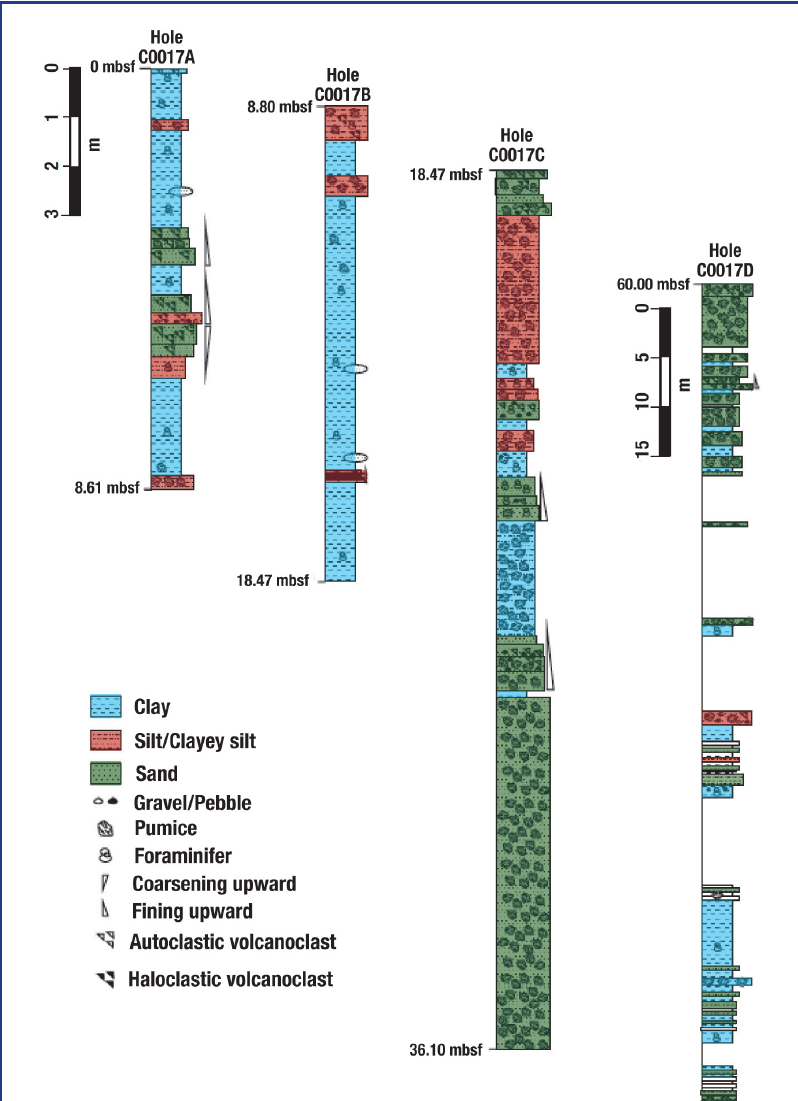
Figure 6. Sedimentary log for Site C0017, showing sediment types. Modified from Takai et al.